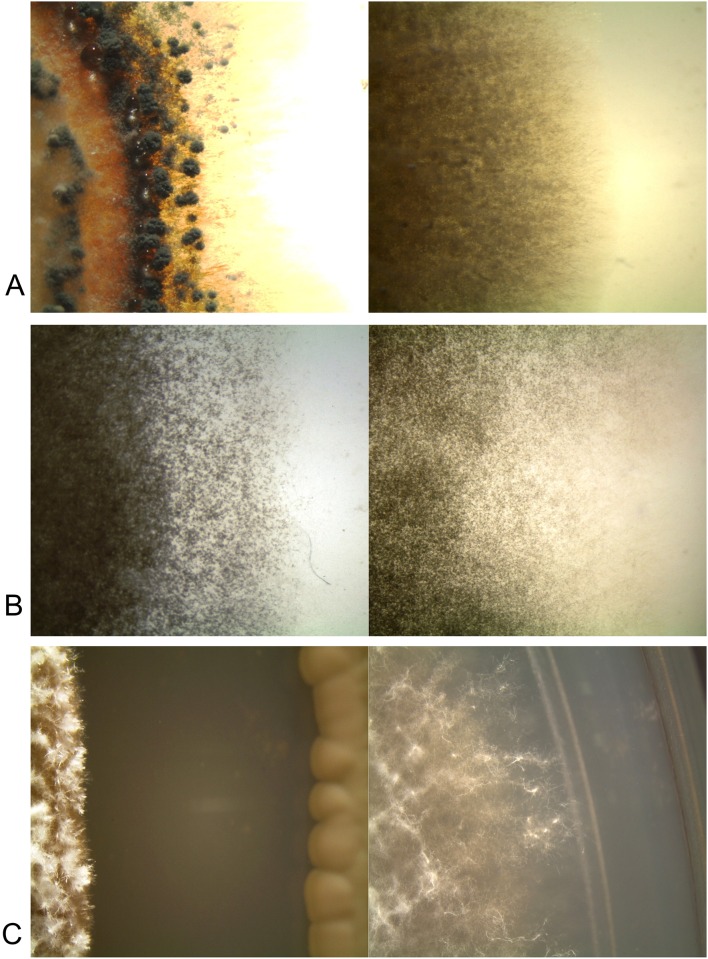
In vitro inhibition of killer yeast 137 against fungi on PDA medium (10 days of incubation at 25°C) under loupe (10X magnification).To the left is shown the mycelium from P. italicum (A), P. digitatum (B), and P. citri (C) inhibited by killer yeast 137. To the right control mycelia from each fungus are shown.